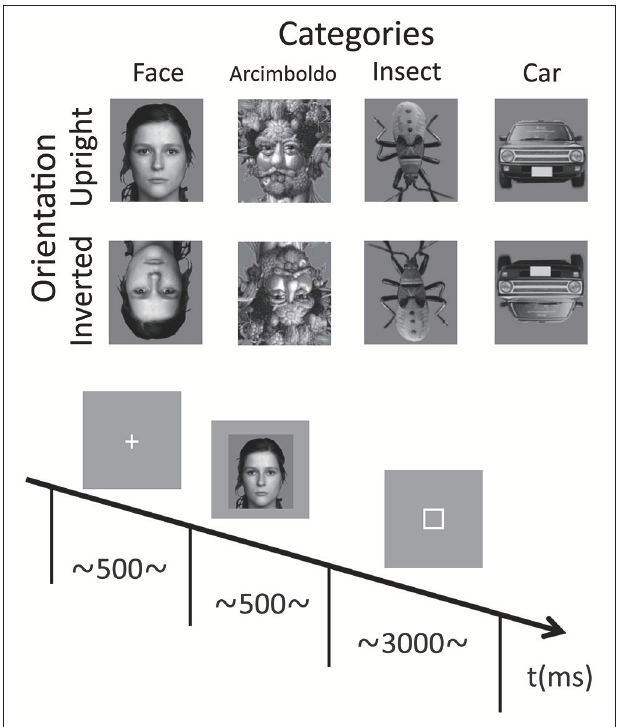
FIGURE 1 | Example stimuli for each category and the timeline of stimulus presentation during a single trial. The face category was selected from the FACES database (Max Planck Institute for Human Development, Berlin; Ebner et al., 2010 ). Only faces with neutral expression were chosen (interrater agreement N 0.90, as published for the reference sample). The car category was selected as representing artificial objects, and the insect category was selected as representing natural objects. The Arcimboldo paintings were selected for observing holistic and feature processing, as described by Caharel et al. (2013) and Rossion et al. (2011). Images for each condition were randomly presented, and the participants performed the